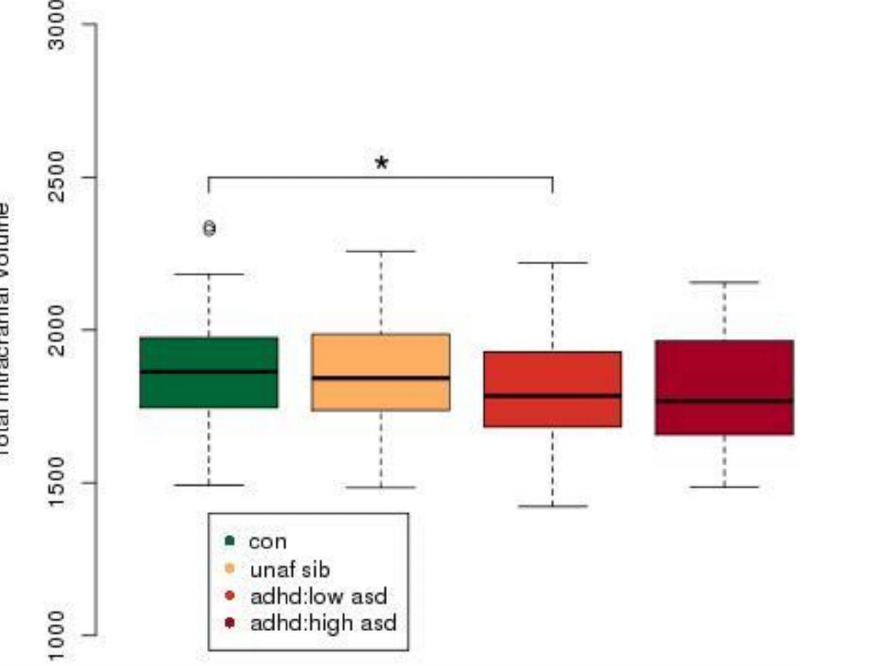
Figure 5. ADHD subjects with low ASD scores have significantly lower total intracranial volume than control subjects (p , 0.05). ADHD: low ASD is defined as a participant with ADHD and an ASD score of 20 or less. ADHD: high ASD is defined as a participant with ADHD and an ASD score greater than 20.